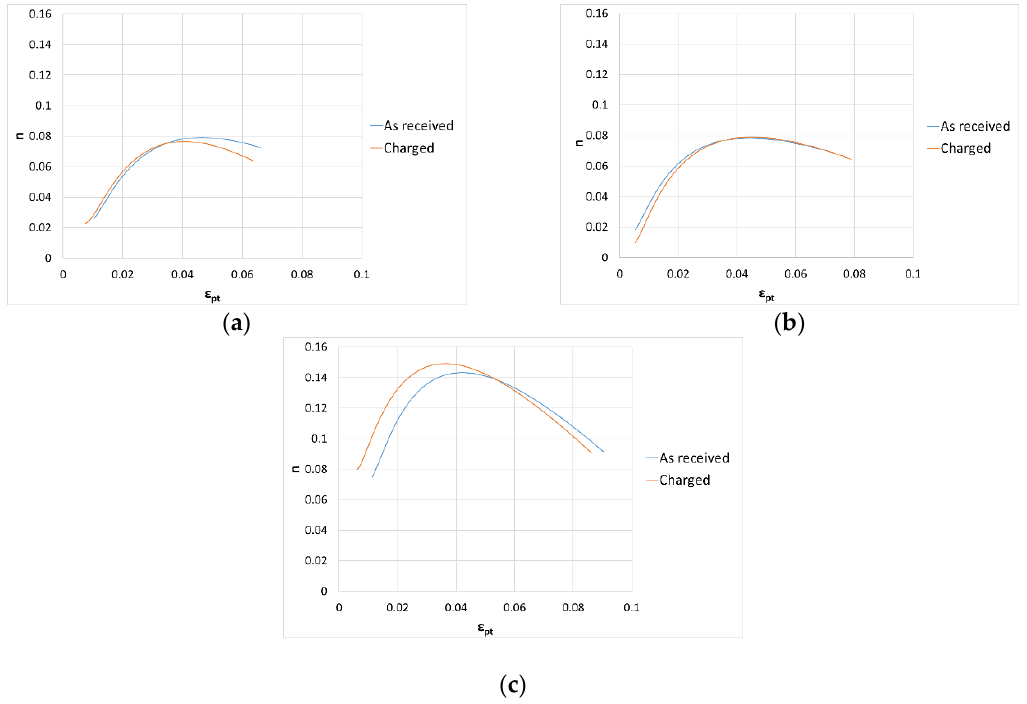
Figure 13. Instantaneous strain hardening coefficient as a function of plastic strain. Comparison between as-received material and after hydrogen charging under Mg cathodic protection at 60 °C for ( a ) group I, ( b ) group X and ( c ) group O.